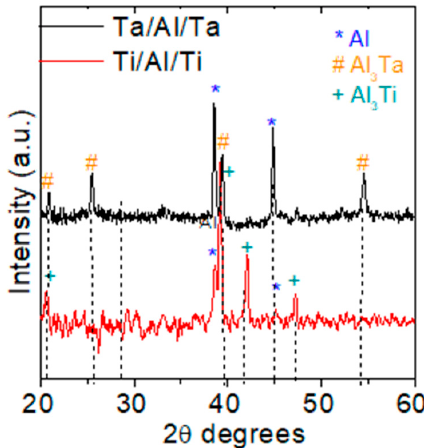
Figure 5. X-ray di ff raction (XRD) patterns for Ta / Al / Ta and Ti / Al / Ti contacts annealed at 600 ◦ C, showing Figure 5. X-ray diffraction (XRD) patterns for Ta/Al/Ta and Ti/Al/Ti contacts annealed at 600 °C, the appearance of the Al 3 Ta and Al 3 Ti phases. showing the appearance of the Al 3 Ta and Al 3 Ti phases.